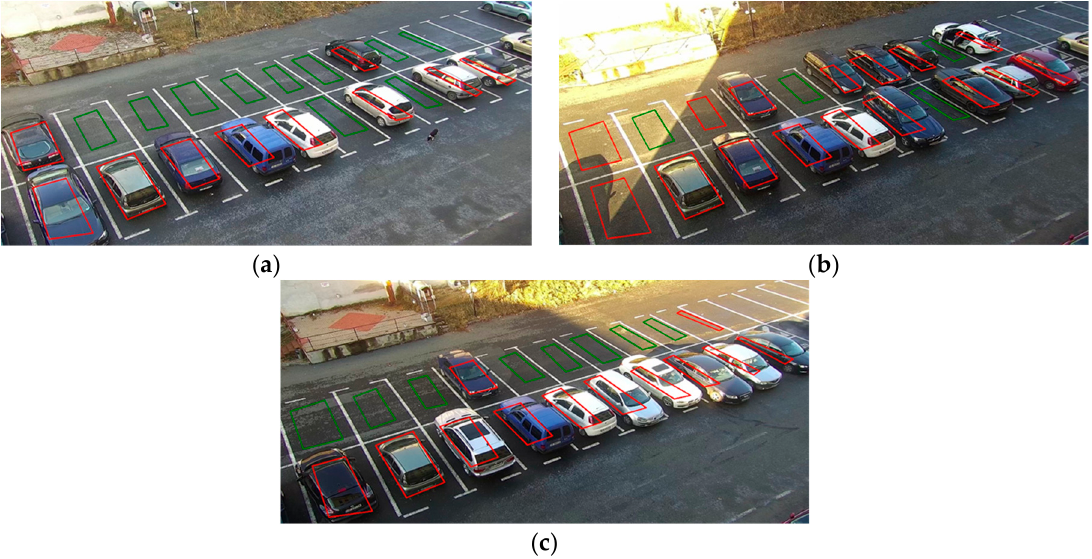
Figure 13. Detection of parking lot 1 availability: ( a ) the before direct sunlight; ( b ) with direct sunlight; ( c ) at the end of the day.